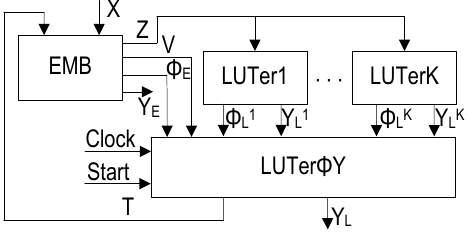
Figure 6. Structural diagram of Mealy FSM U 5